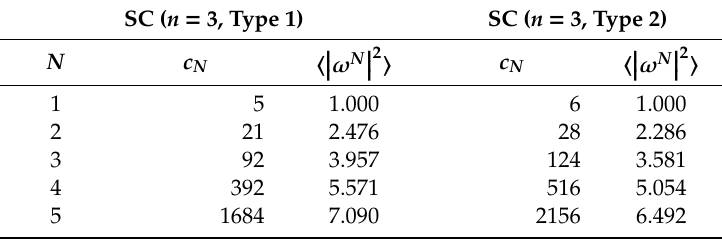
Table A4. Properties of SAWS on SC lattice with 3 layers between the confining plates ( n = 3, Type 1,